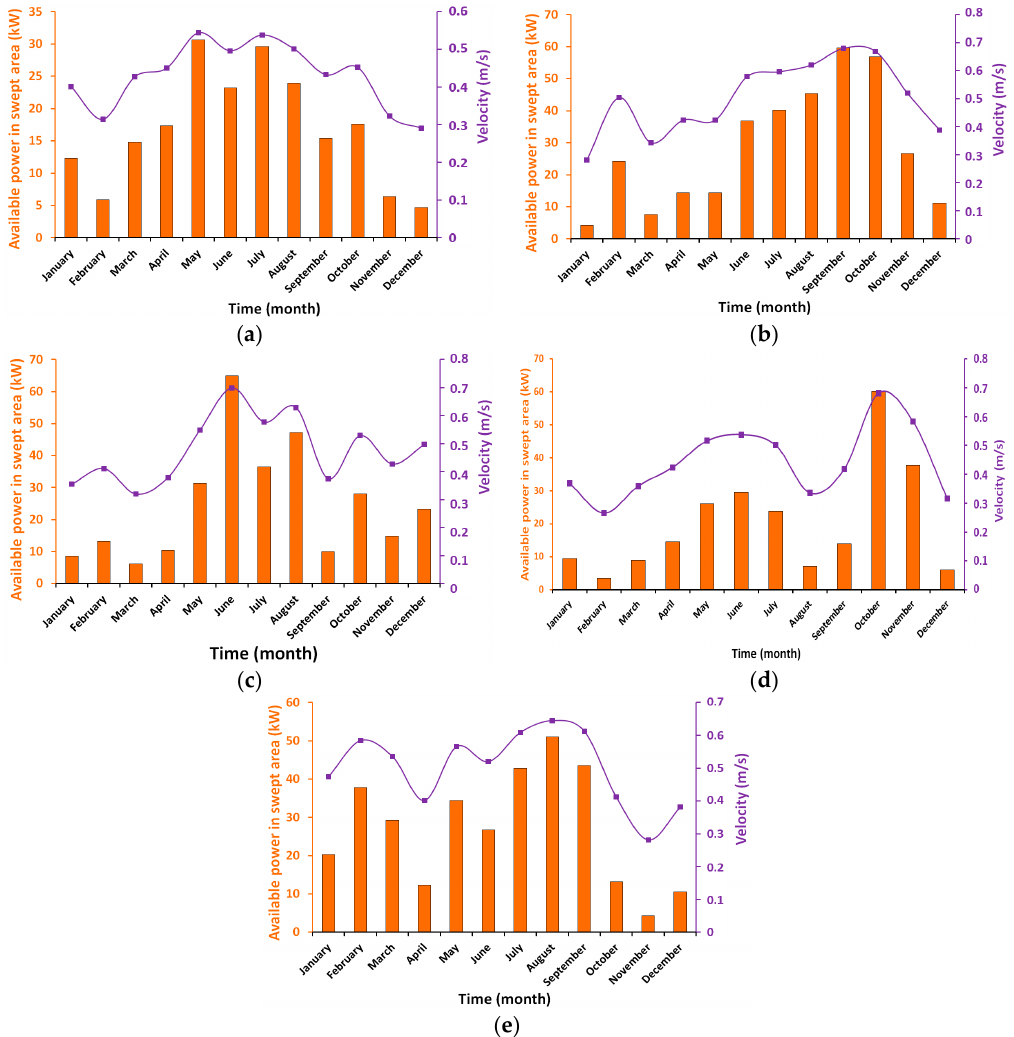
Figure 8. Tidal energy resource in the north coast of Atlantic. ( a ) 2010; ( b ) 2011; ( c ) 2012; ( d ) 2013; ( e ) 2014.